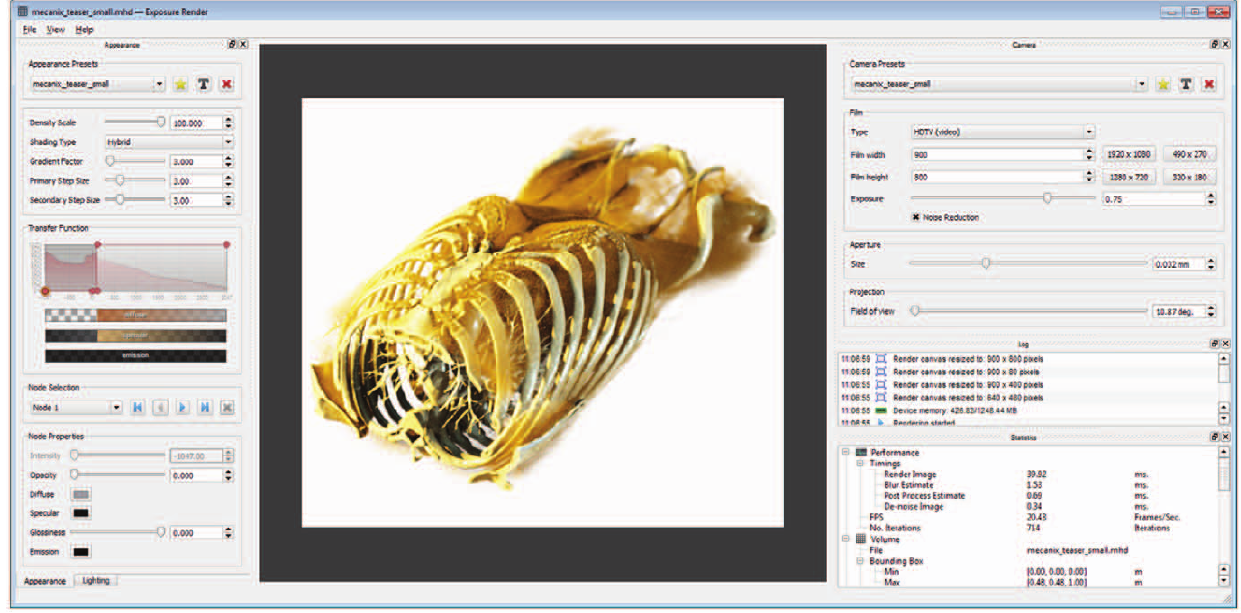
Figure 10. Screenshot of the Exposure Render graphical user interface.